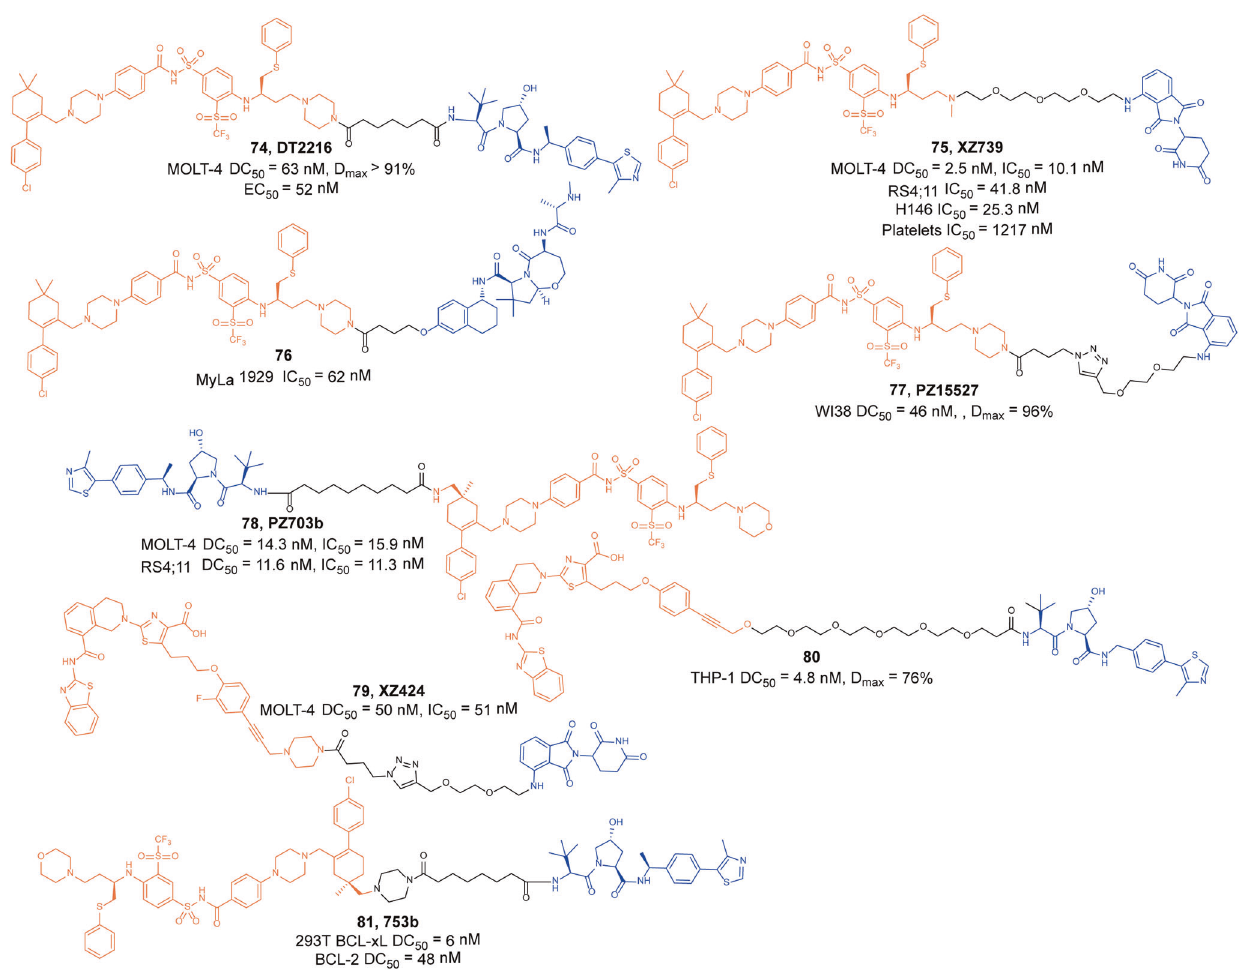
Fig. 20 The representative PROTACs targeting Bcl-xl